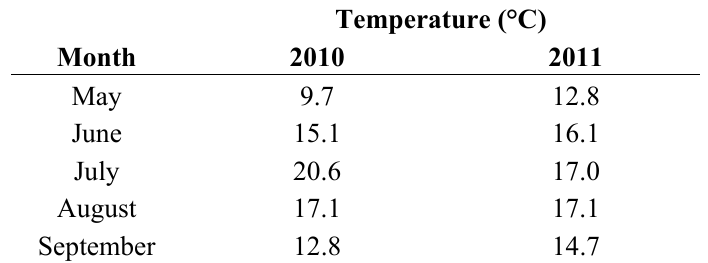
Table 1. Mean temperature during the growing season in 2010 and 2011.